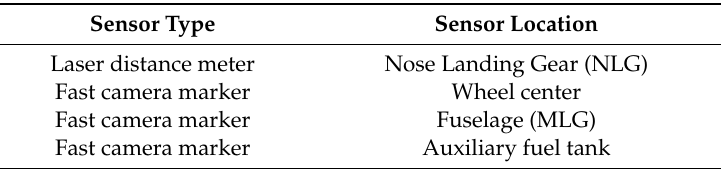
Table 4. Comparison